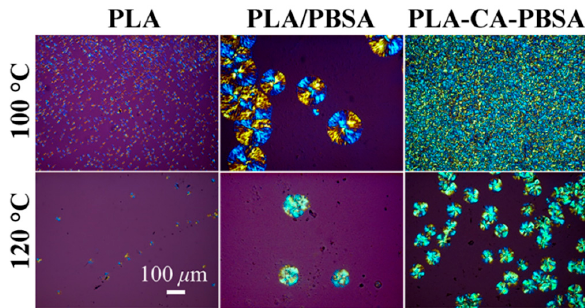
Figure 3. Crystalline morphology of isothermal crystallization at 100 and 120 °C of neat PLA, PLA/PBSA and PLA-CA-PBSA by polarized optical microscopy.